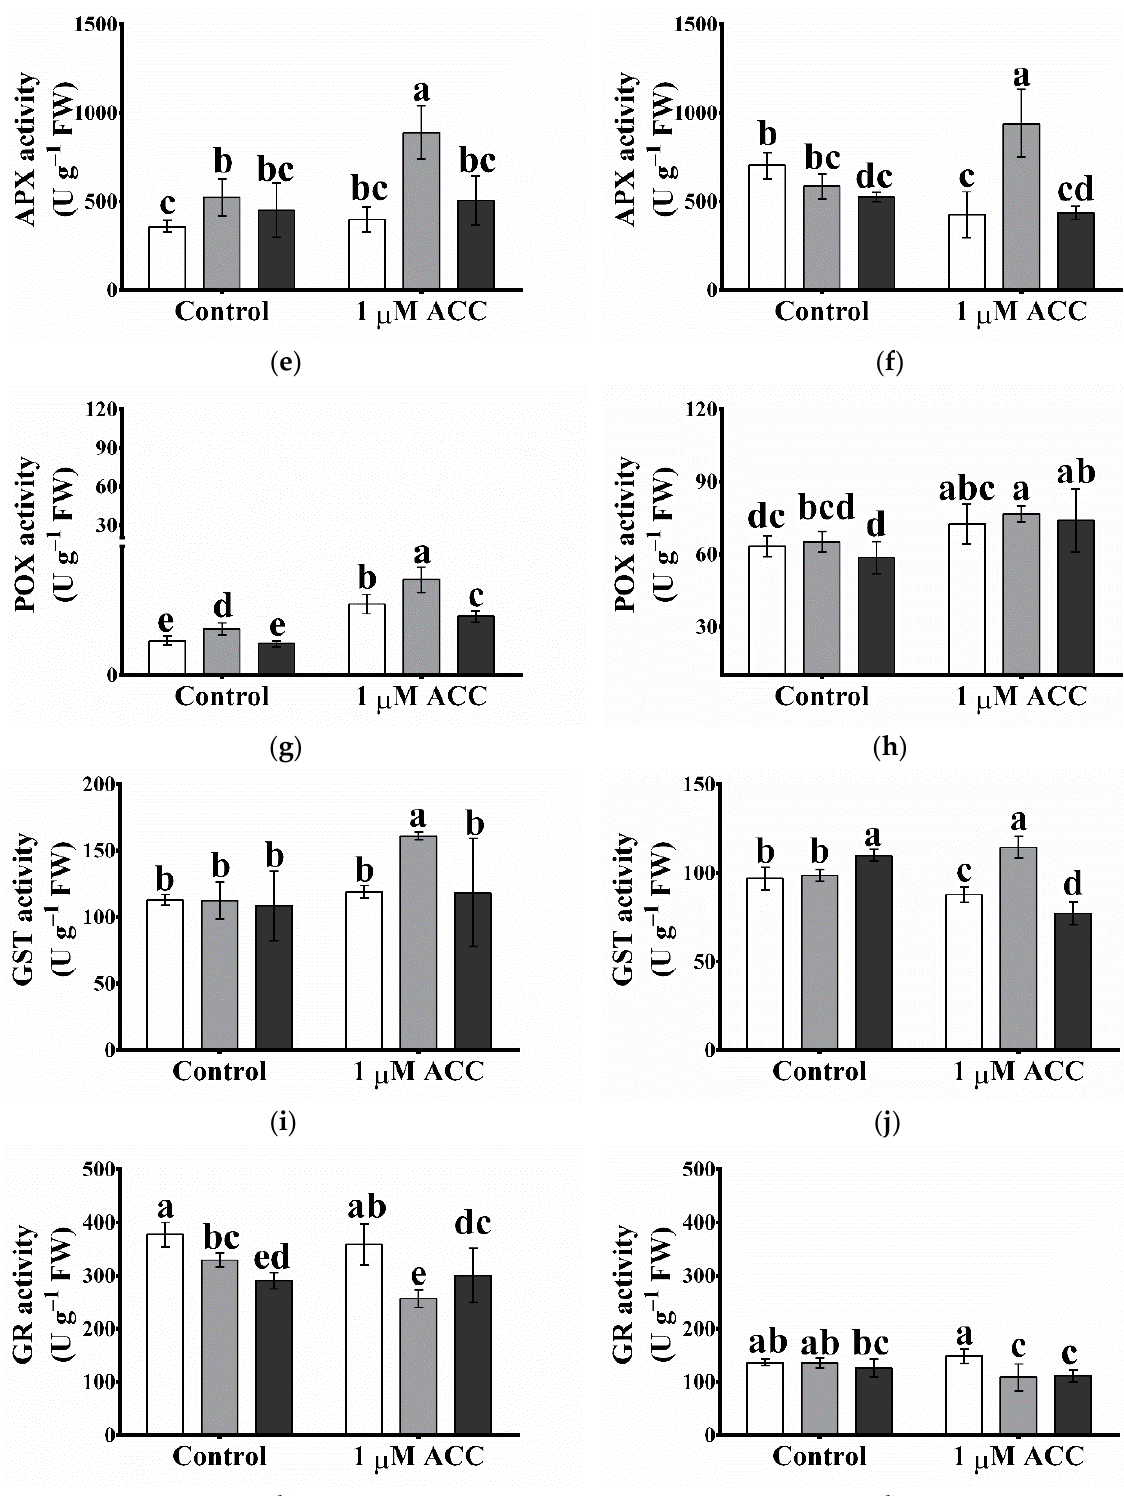
Figure 9. Effect of one-day 1 µ M ACC treatment on the catalase ( a , b ), superoxide dismutase ( c , d ), ascorbate peroxidase ( e , f ), guaiacol peroxidase ( g , h ), glutathione transferase ( i , j ) and glutathione reductase ( k , l ) activities in shoots and roots, respectively, of 6-week-old Arabidopsis thaliana wild type (Col-0), Atgpxl5-1 mutant ( Atgpxl5 ) and OX-AtGPXL5 plants. The data are presented by mean values ± SD, n = 3. Data were analysed using one-way ANOVA followed by Duncan’s test. Different letters represent data considered statistically significant at p ≤ 0.05. n.s: statistically not significant.